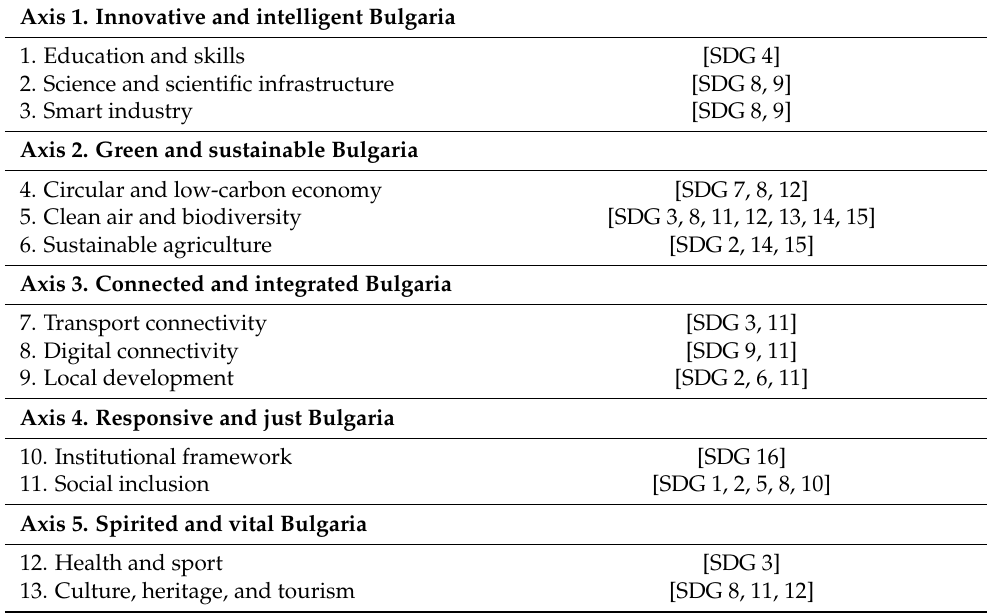
Table 2. Bulgaria 2030 objectives, axes, and priorities and link to